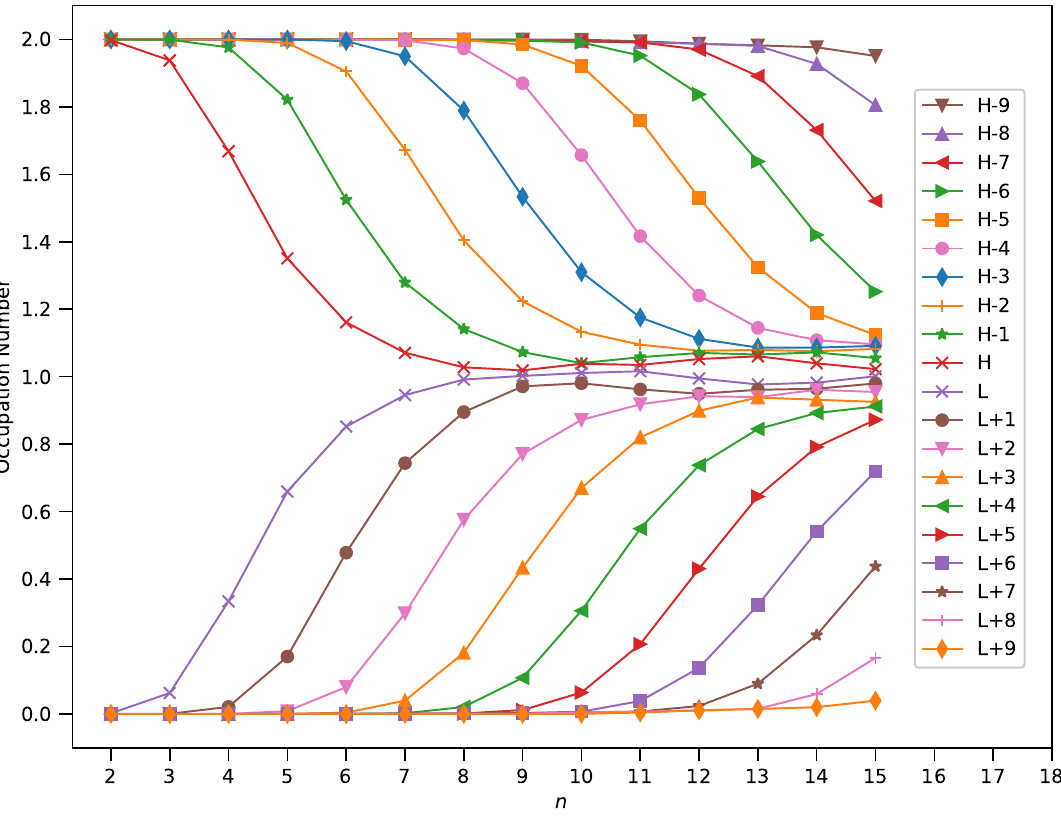
Figure 7. Active orbital occupation numbers (H − 9, H − 8, ..., H, L, ..., L+8, and L+9) of ground-state n -pyrene, calculated by spin-restricted TAO-LDA. HOMO/LUMO is denoted as H/L for